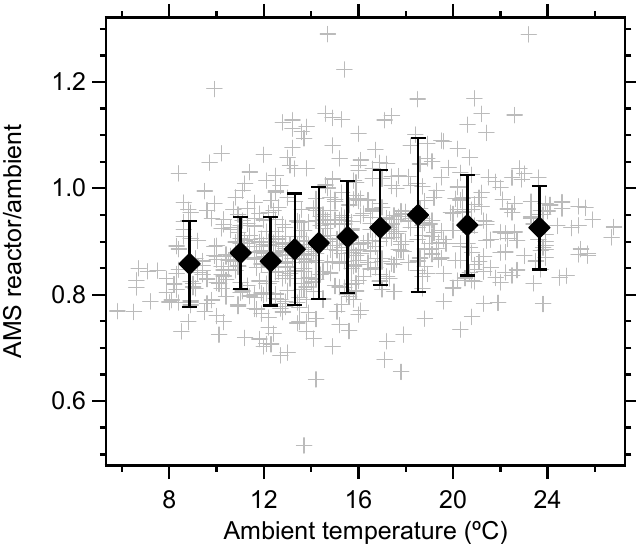
Figure 4. Ratio between reactor and ambient total AMS mass concentrations (hourly values, loss corrected) as a function of temperature. 10% temperature quantiles show a significant trend below 18 °C.